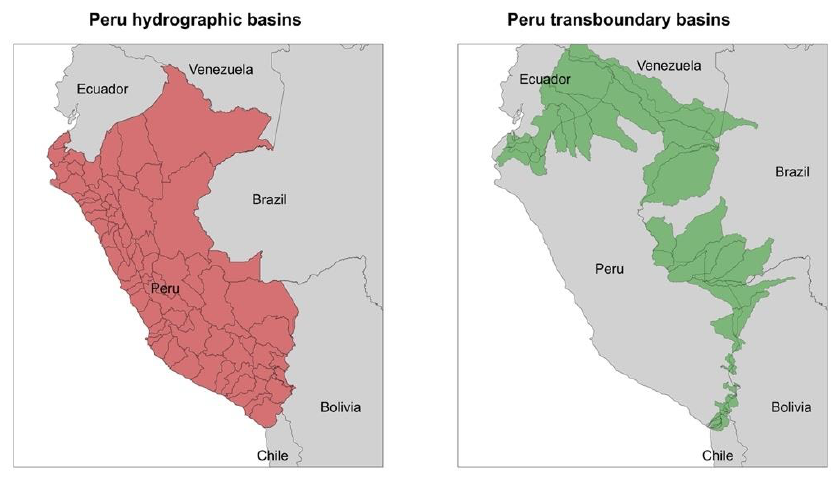
Figure 7. Peruvian hydrographic basins. The country’s borders are depicted in red. Its transboundary basins are depicted in green.